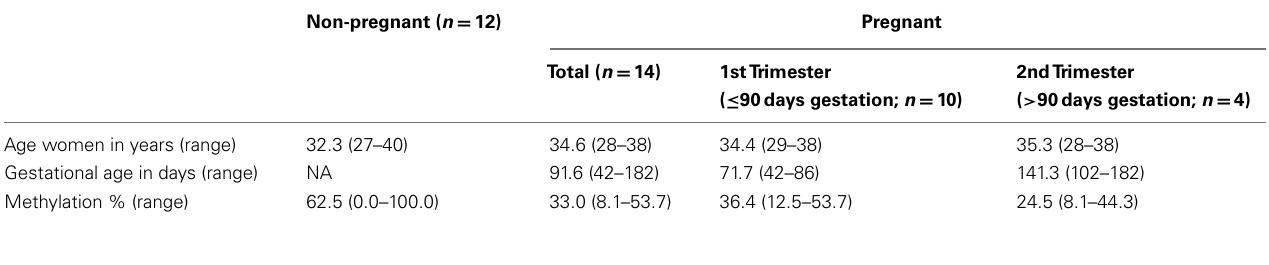
Table 1 | Characteristics of plasma samples